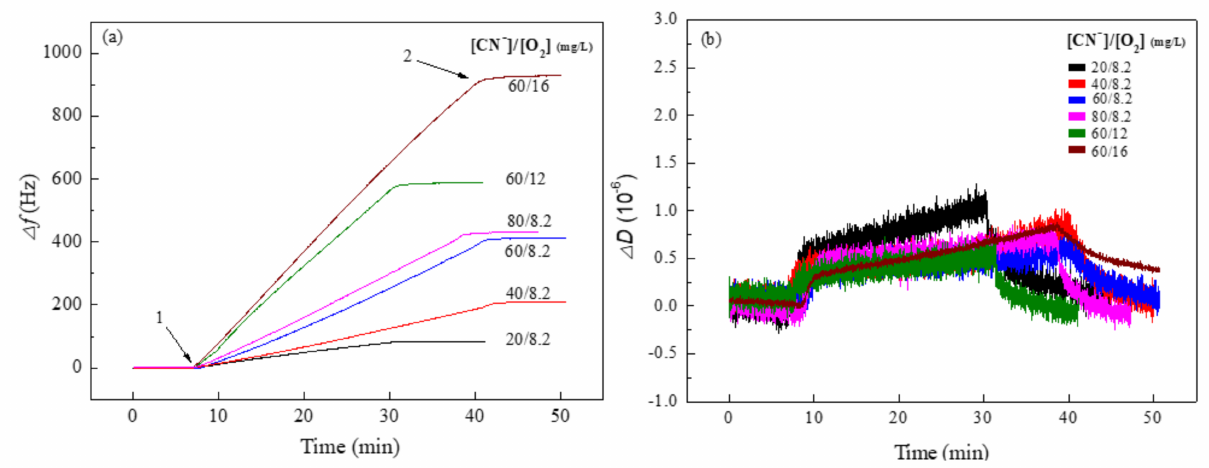
Figure 7. QCM-D data showing the changes in frequency, ∆ f ( a ) and dissipation, ∆ D ( b ), for different [CN − ]/[O 2 ] values in the injection